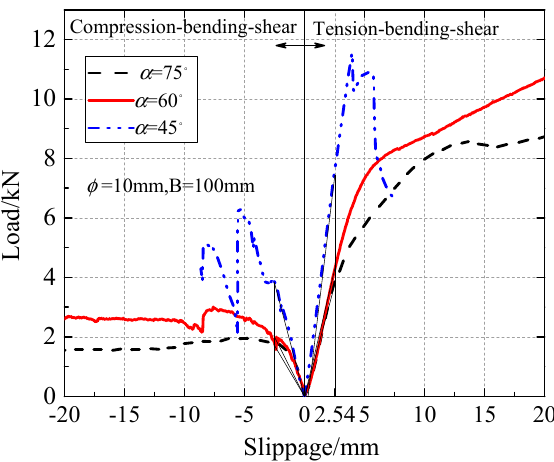
Figure 10. Comparison of load-displacement curves.